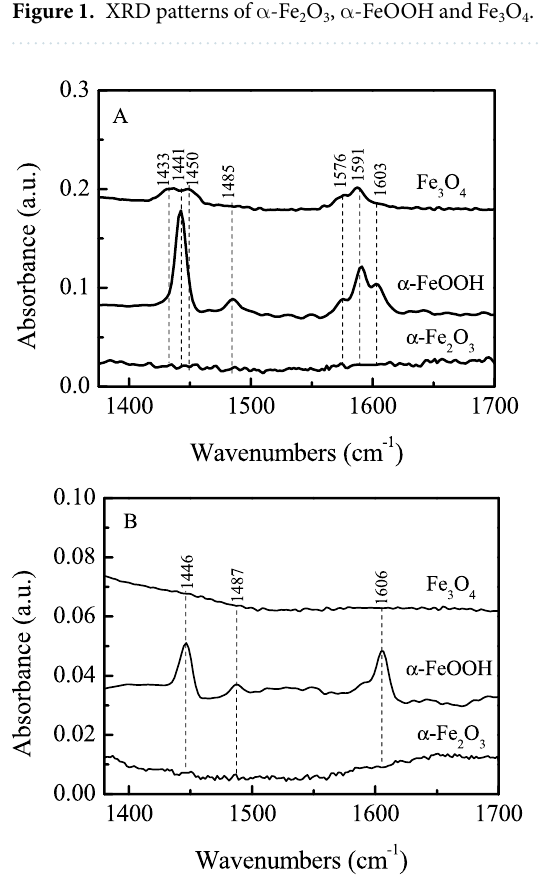
Figure 1. XRD patterns of α -Fe 2 O 3 , α -FeOOH and Fe 3 O 4 .